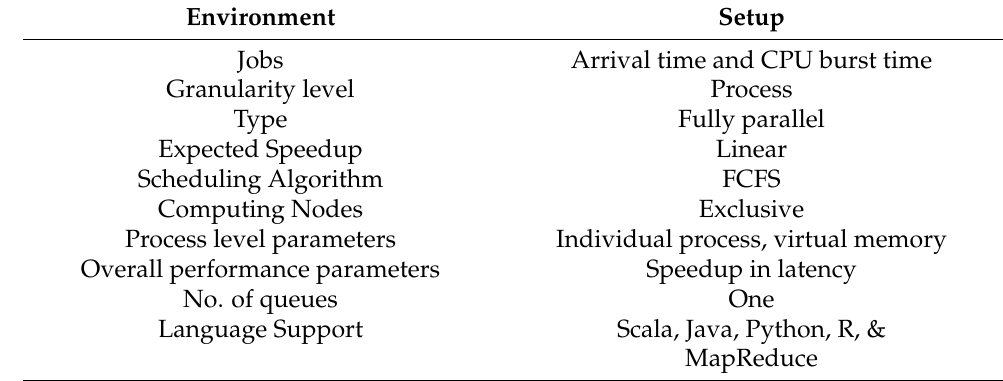
Table 3. Experimental